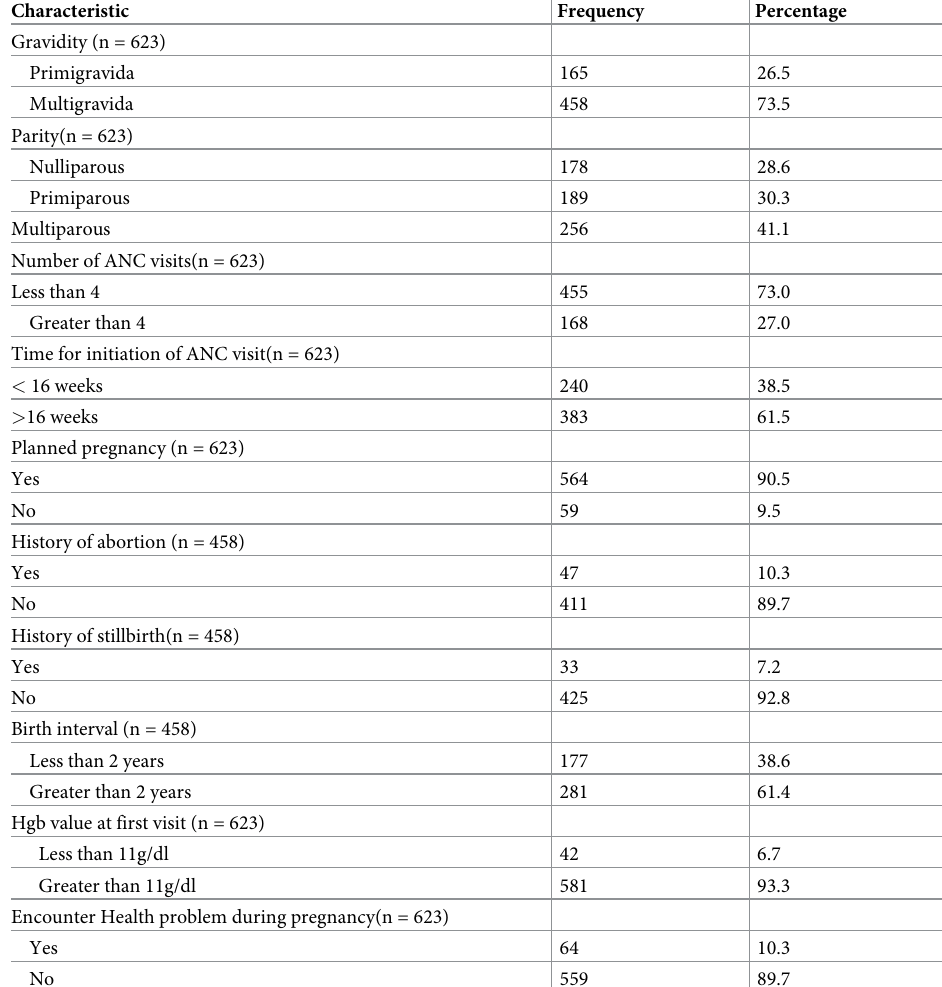
Table 2. Obstetrics and health relatedcharacteristics of ANC attending pregnant mothers, in governmental health institution of Adwa town, Northern Ethiopia, 2018.